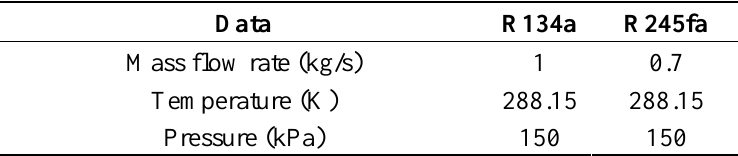
Table 2. Inlet cooling water main